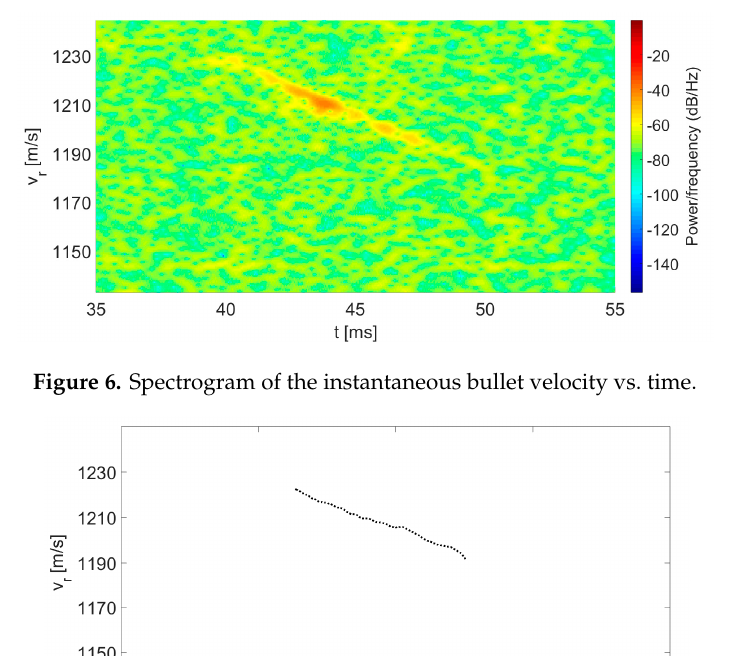
Figure 7. The instantaneous velocity of the fired bullet as a function of time.